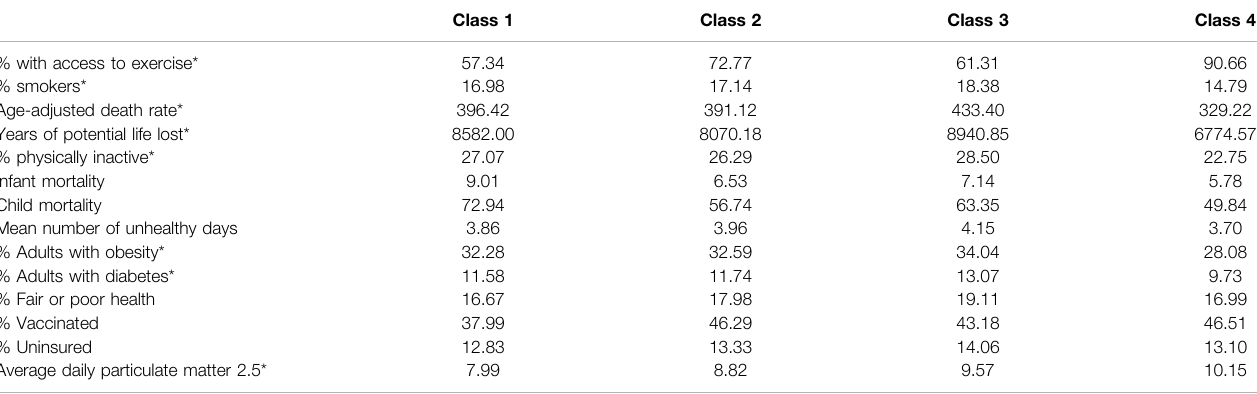
TABLE 7 | Means of health outcome variables by latent class.